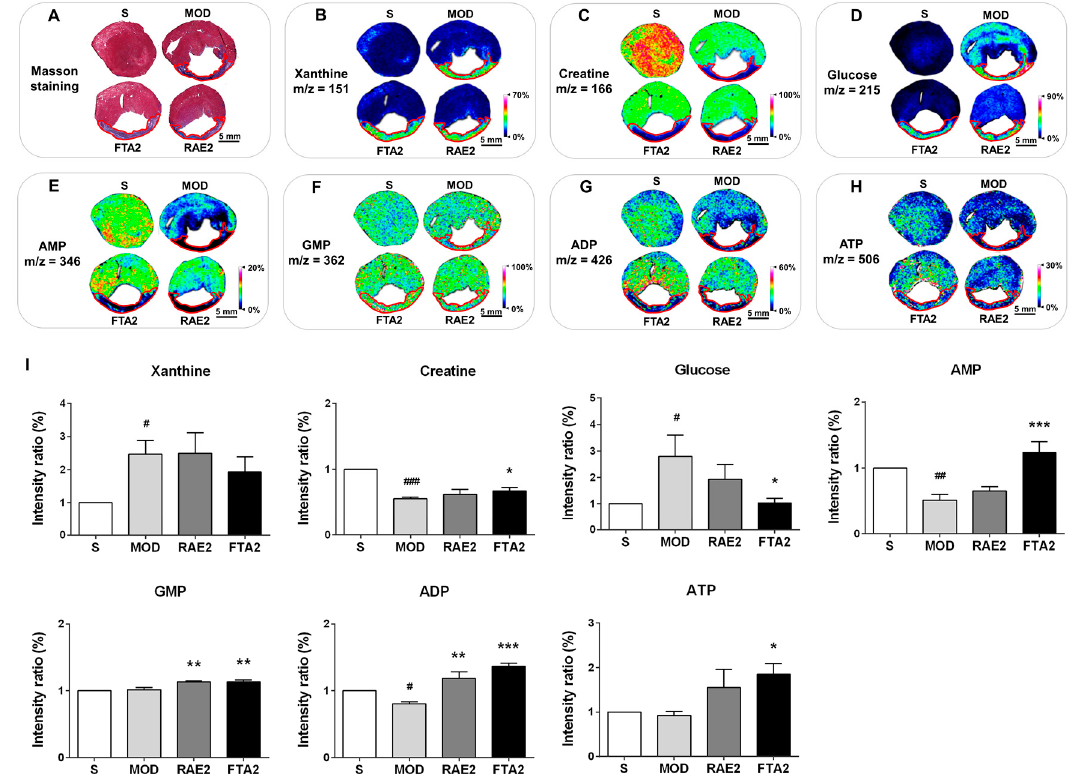
Figure 6. RAE and FTA regulated energy metabolism-related molecules. ( A ) Masson staining of adjacent heart slices. In situ matrix-assisted laser desorption / ionization–mass spectrometry imaging (MALDI–MSI) of ( B ) glucose, ( C ) GMP, ( D ) ATP, ( E ) AMP, ( F ) ADP, ( G ) xanthine, and ( H ) creatine. ( I ) Relative intensity ratios of these molecules were normalized and analyzed using SCiLS Lab. Spatial resolution = 200 µ m; scale bar = 5 mm. m / z : mass-to-charge ratio. S, sham surgery group; MOD, MI model group; RAE2, 0.8 g / kg Radix Aconiti Lateralis Preparata extract group; FTA2, 0.8 g / kg fuzi total alkaloid group. Data are presented as mean ± standard error of the mean; n = 3 per group. # p < 0.05, ## p < 0.01, ### p < 0.001 vs. S group; * p < 0.05, ** p < 0.01, *** p < 0.001 vs. MOD group.